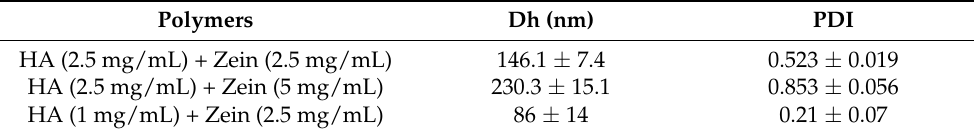
Table 1. Dh and PDI of the NPs with different polymer concentrations. Data are presented as mean ± SD ( n =